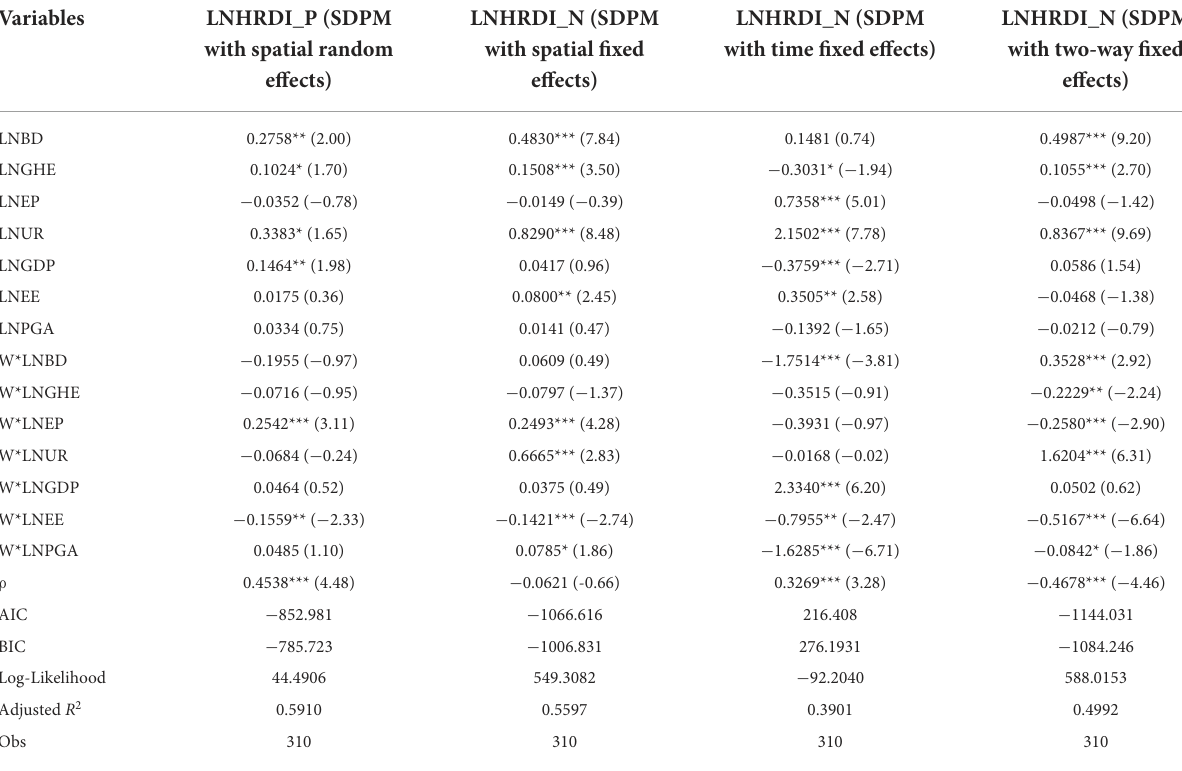
TABLE 5 Spatial econometric models for HRDI_P and HRDI_N.